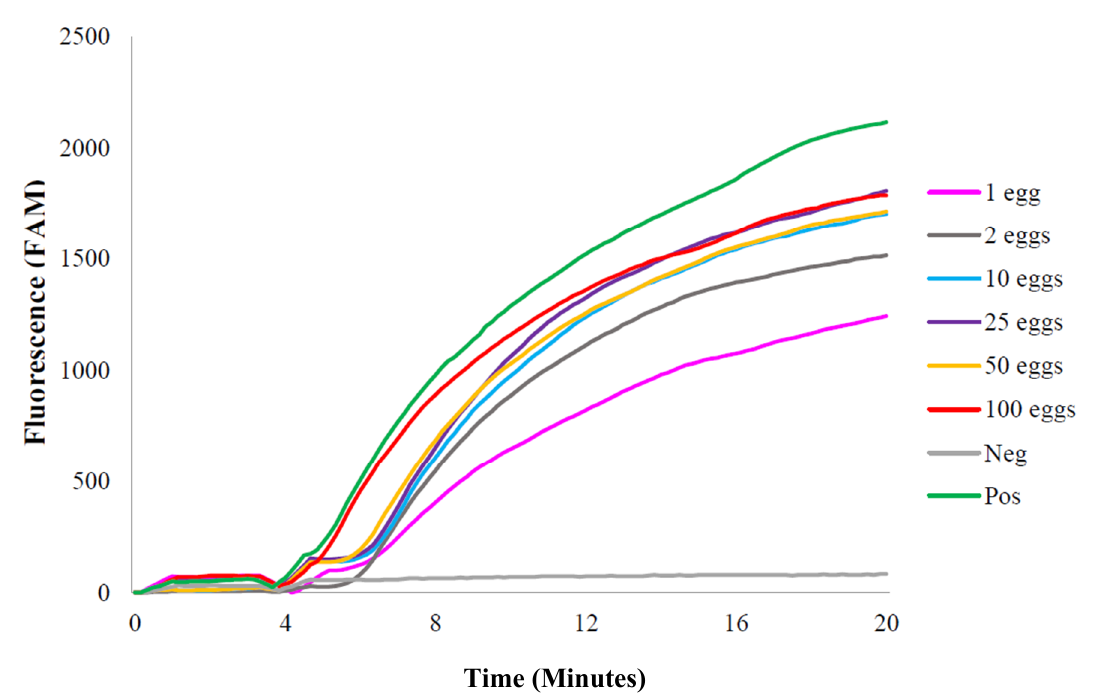
Figure 2. Laboratory-prepared Schistosoma haematobium ova-spiked sample plots using RT-ShDra1-RPA assay. All quantities of laboratory-prepared S. haematobium ova-spiked samples were successfully detected and amplified. The positive DNA control (‘Pos’) was also detected and